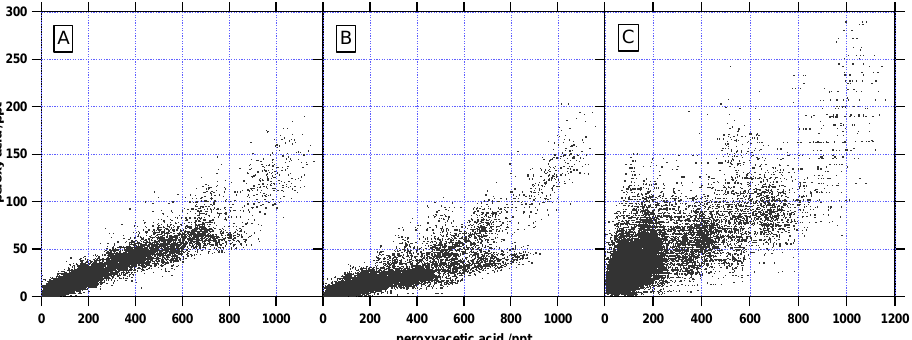
Fig. 8. Relationship between (A) PPA vs. PAA, (B) PBA vs. PAA, and (C) MPA vs. PAA for all data during HUMPPA-COPEC assuming the same PAA-equivalent instrument sensitivity for all